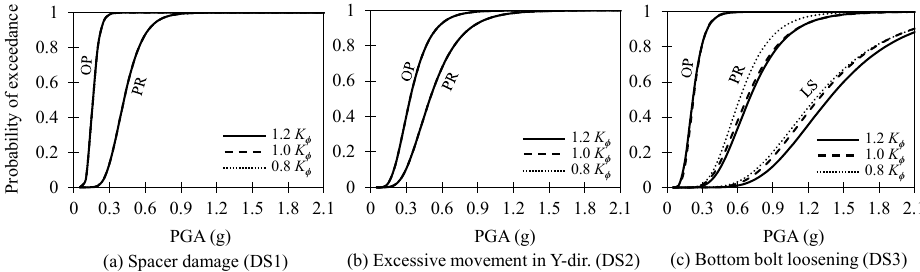
Figure 22. Effect of variation of effective translational stiffness on fragility curves of the mold transformer.